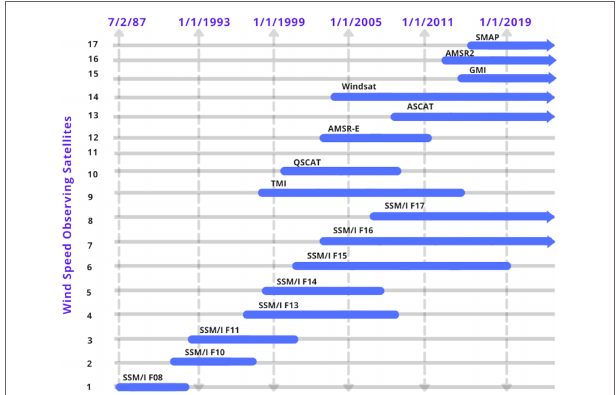
FIGURE 1 | The primary U.S. wind speed observing satellites. Observations from these satellites are used to produce NBS products. The arrow represents data that are currently available into the future in near-real-time.